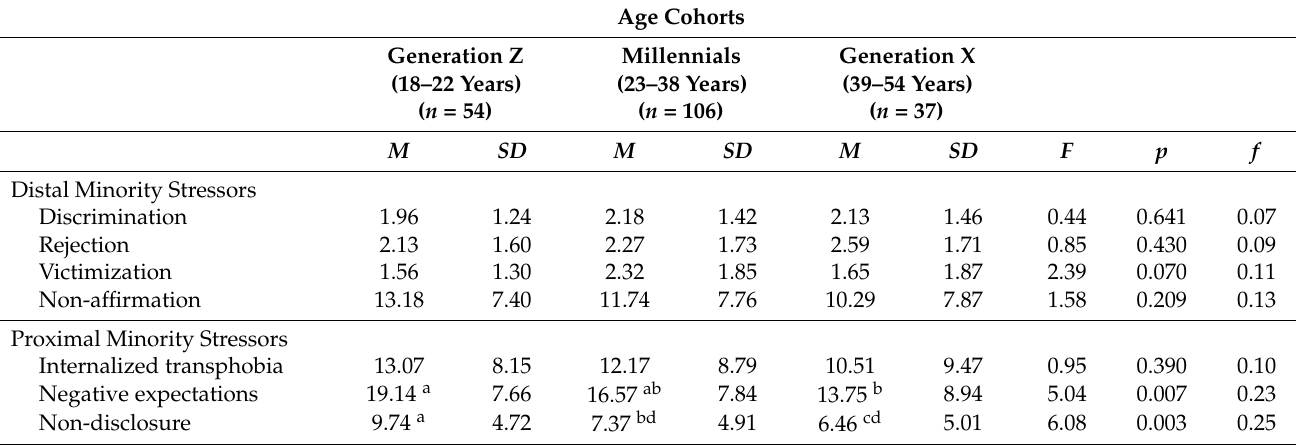
Table 4. Associations between minority stress and generational